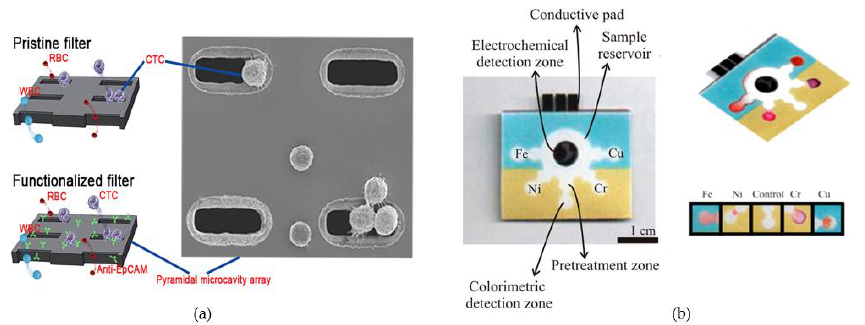
Figure 6. ( a ) Filter process of the pristine filter and the functionalized filter; ( b ) microfluidic paper- based analytical device for toxic metals detection. ( a ) Reproduced with permission. [225] Copyright 2019, Anal Chim Acta. ( b ) Reproduced with permission. [40] Copyright 2014, Anal Chem.